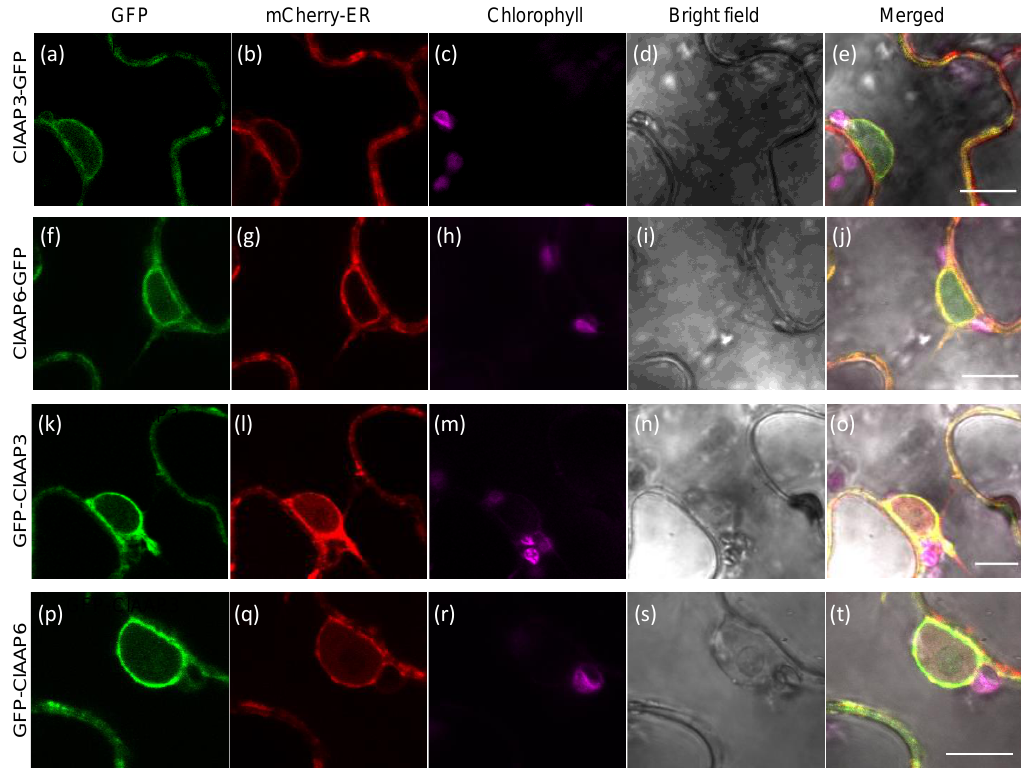
Figure 6. Subcellular localization of GFP-tagged ClAAP3 and ClAAP6 The signal from GFP ( a ), ( f ), ( k ), ( p ); mCherry ( b ), ( g ), ( l ), ( q ); Chlorophyll ( c ), ( h ), ( m ), ( r ); bright field ( d ), ( i ), ( n ), ( s ) channels, and the merged picture ( e ), ( j ), ( o ), ( t ) are shown. ( a ) to ( e ): Nicotiana benthamiana leaf epidermal cells co-expressing ClAAP3-GFP and mCherry-HDEL (ER marker). ( f ) to ( j ) Nicotiana benthamiana leaf epidermal cells co-expressing ClAAP6-GFP and mCherry-HDEL. ( k ) to ( q ) Nicotiana benthamiana leaf epidermal cells co-expressing GFP-ClAAP3 and mCherry-HDEL. ( p ) to ( t ) Nicotiana benthamiana leaf epidermal cells co-expressing GFP-ClAAP6 and mCherry-HDEL Scale bars: 10 μm.